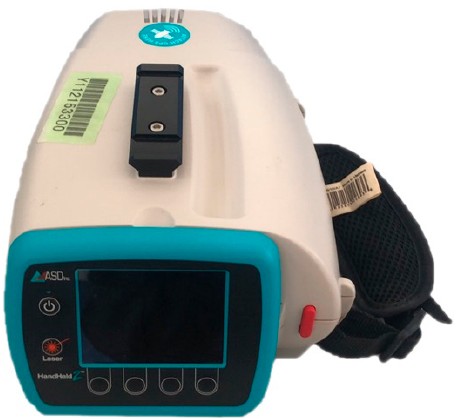
Figure 3. ASD FieldSpec HandHeld2 spectrophotometer.